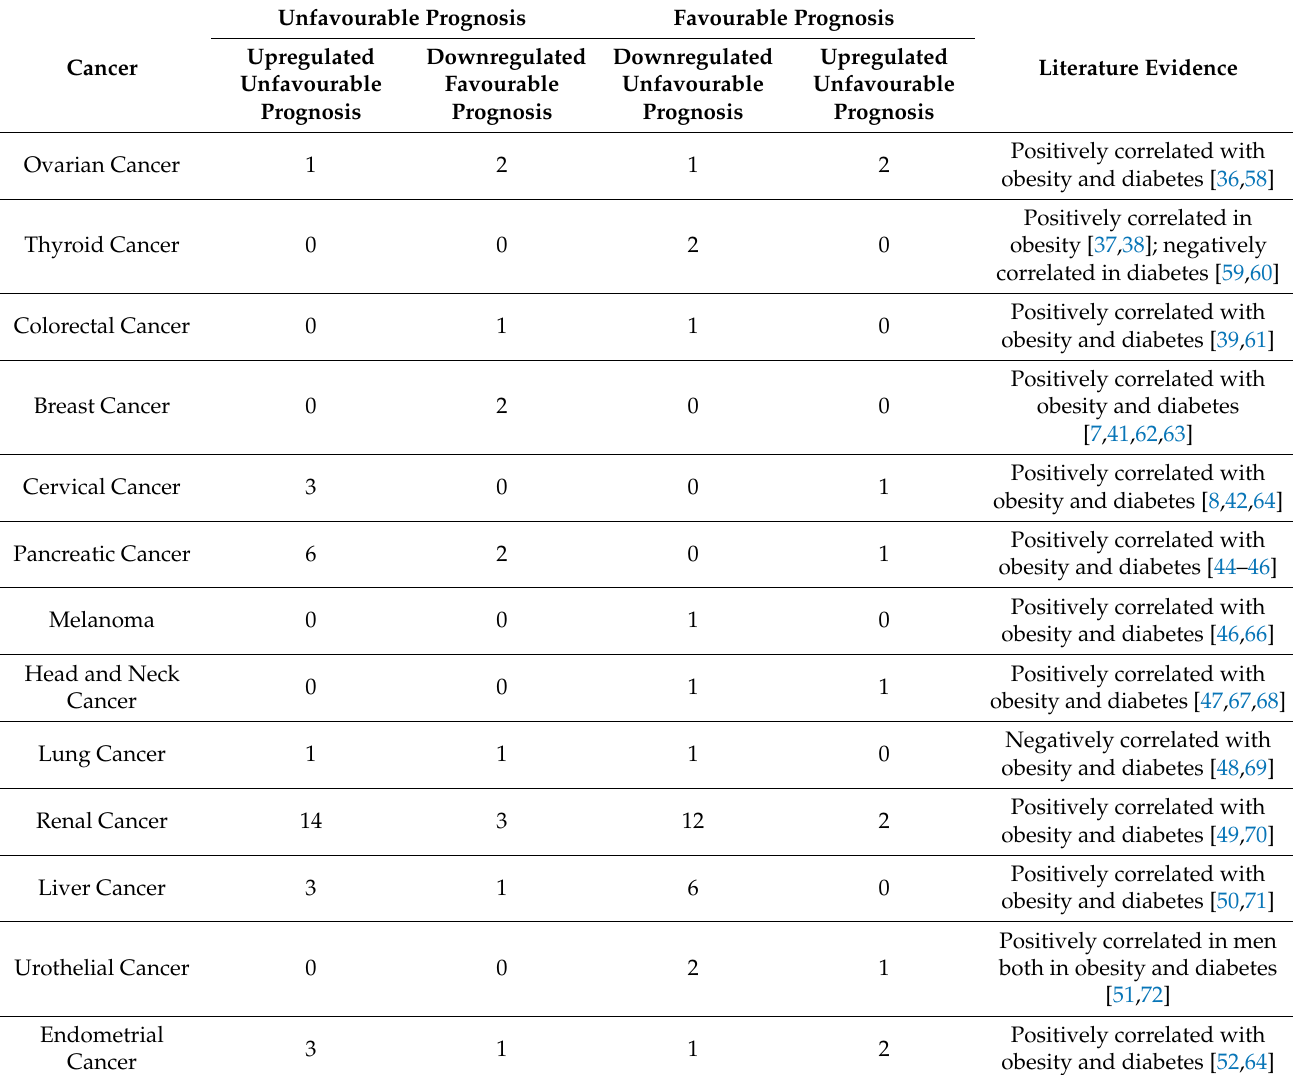
Table 5. Prognosis score and number of deregulated genes associated with each specific cancer. Unfavorable or favorable prognosis was assessed according to orange or blue edges, respectively. Upregulated or downregulated genes were described according to their log2FC. A bibliographic search was performed to assess previous correlations of each cancer type with obesity and/or